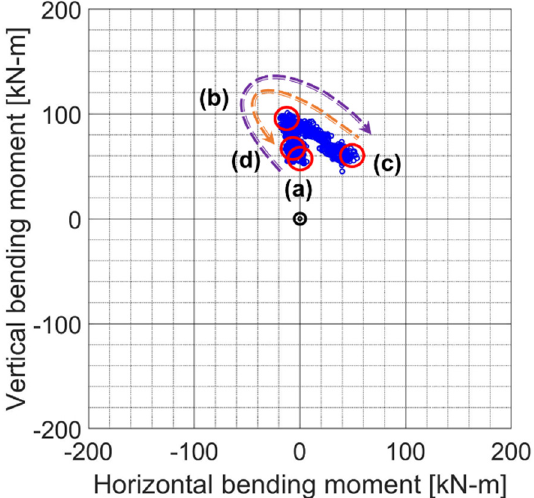
Figure 22. Plot of trajectories obtained during the starboard turn under the normal ballast condition. Stage (a): Rudder angle 0-degree: NCR straight going (begin). Stage (b): Rudder angle changes from 0 to 12-degree (starboard). Stage (c): Rudder angle 12-degree: ship’s heading is gradually changing. Stage (d): Rudder angle 0-degree: NCR straight going (end).